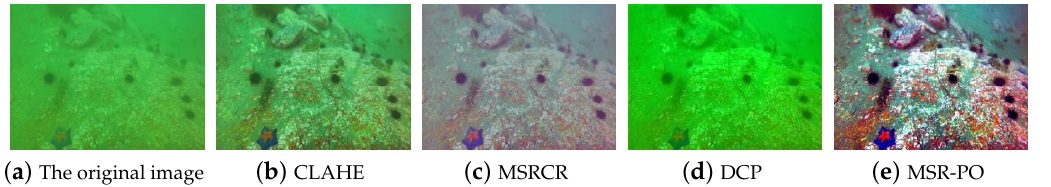
Figure 22. Scene 3 comparison.